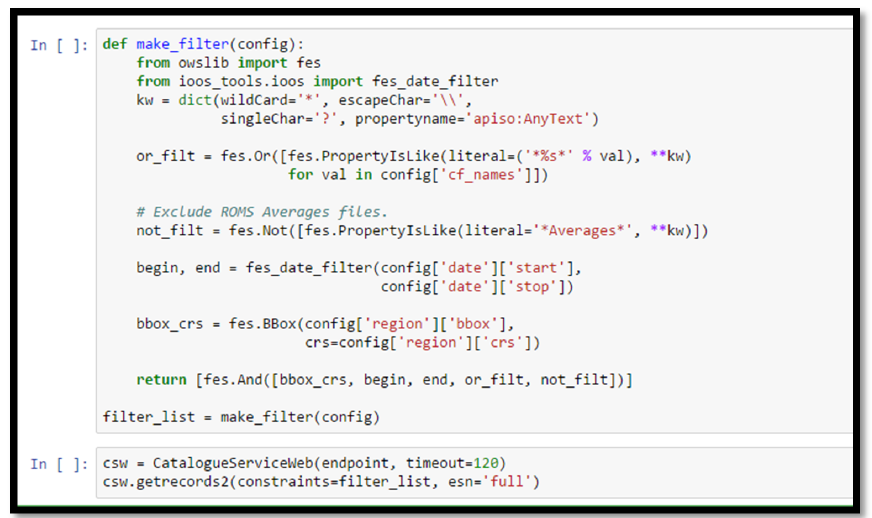
Figure 5. Screenshot from a section of the Fetch Data notebook, illustrating the complex construction of filters used to search only for datasets with specific variable names, bounding box, and temporal extent. Here we additionally exclude datasets that contain the text “Averages” because previous query attempts returned ROMS Averages files that turned out to be versions of ROMS History files that had the tide filtered out. This illustrates the type of customization that many dynamic workflows may require, as catalogs can contain extraneous or duplicate datasets that need be filtered out to effectively use a given workflow.